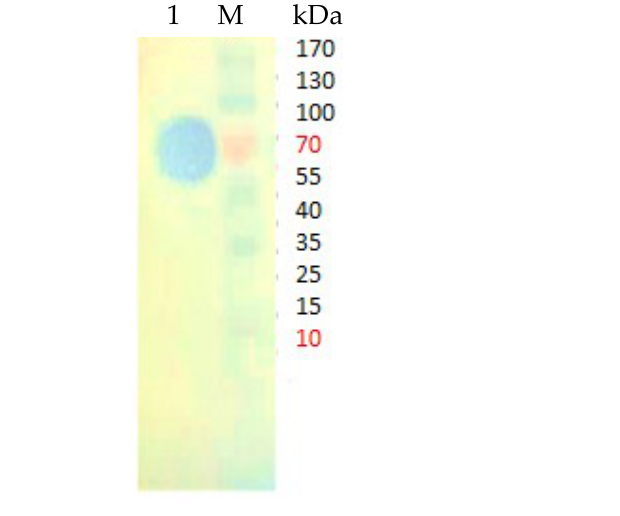
Figure 4. Lane 1: Activity staining with halo zone on purified LSK25 lipase. Lane M: Prestained protein ladder (Thermo Scientific, Waltham, MA, USA); red band ⁓ 10, 70 kDa; blue band ⁓ 15–55, 100–170 kDa.